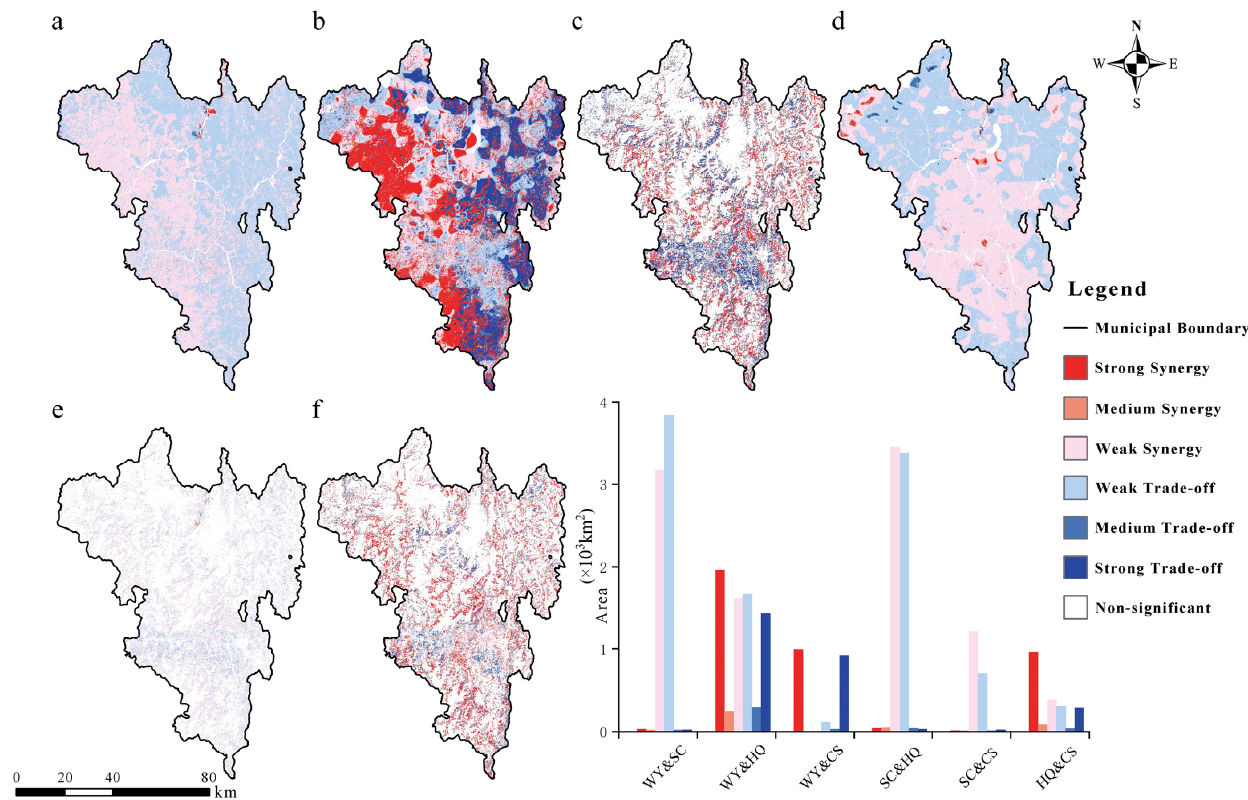
Figure 6. Spatial distribution and statistics of synergy and trade-off relationships. Note: ( a ): WY&SC; ( b ): WY&HQ; ( c ): WY&CS; ( d ): SC&HQ; ( e ): SC&CS; ( f ): HQ&CS.